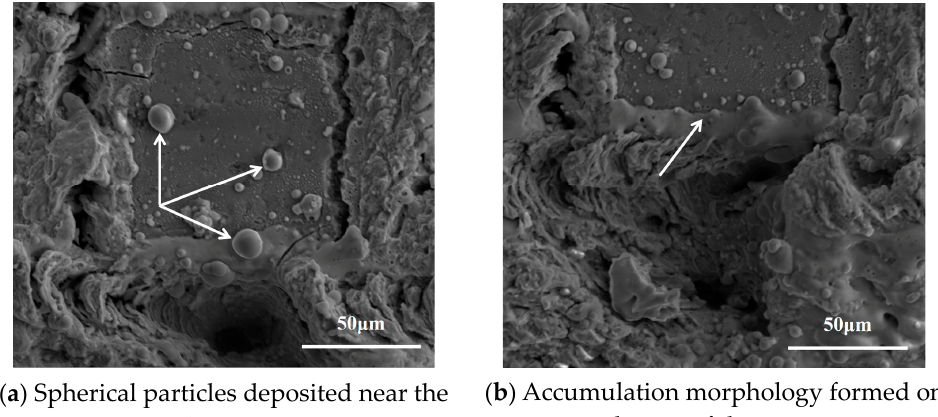
Figure 6. Flow fi eld velocity of the melt pool. (Average power = 8 W, pulse width = 40 ns, frequency = 150 kHz, scanning speed = 100 mm/s).